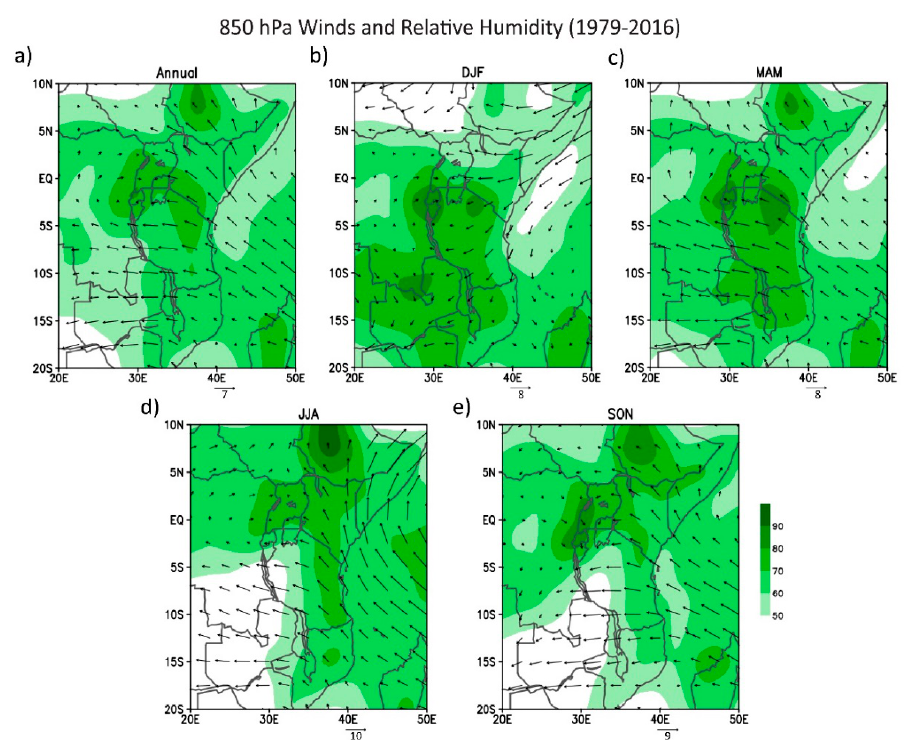
Figure 3. Annual and seasonal 850-hPa winds (vectors) and relative humidity (shaded) climatology calculated from 1979–2016 Reanalysis 1 (R1) data. ( a ) Annual patterns, ( b ) Dec–Feb summer patterns, ( c ) Mar–May fall patterns, ( d ) Jun–Aug winter patterns, and ( e ) Sep–Nov spring patterns. Winds are in m/s. Relative humidity is expressed as percent.